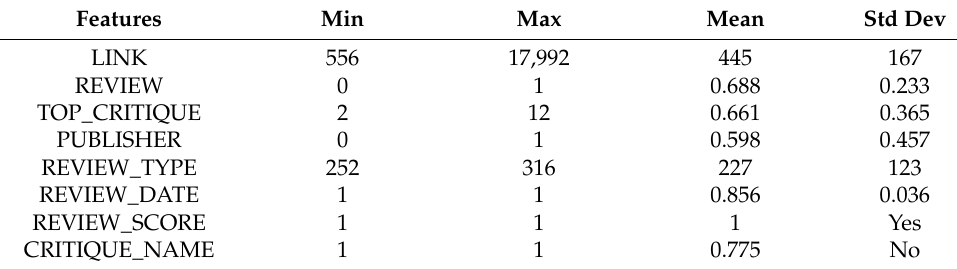
Table 4. Statistical analysis of features of rotten tomatoes movie